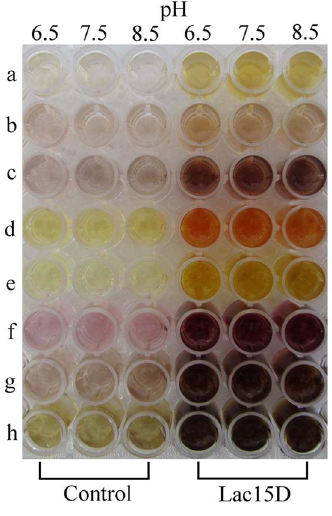
Figure 5. The result of the chromogenic reaction of Lac15D for the dye combination. (a) DMP. (b) OAP. (c) PPD. (d) PAP. (e) OPD. (f) PPD and DMP. (g) PPD and OAP. (h) PPD and PAP.